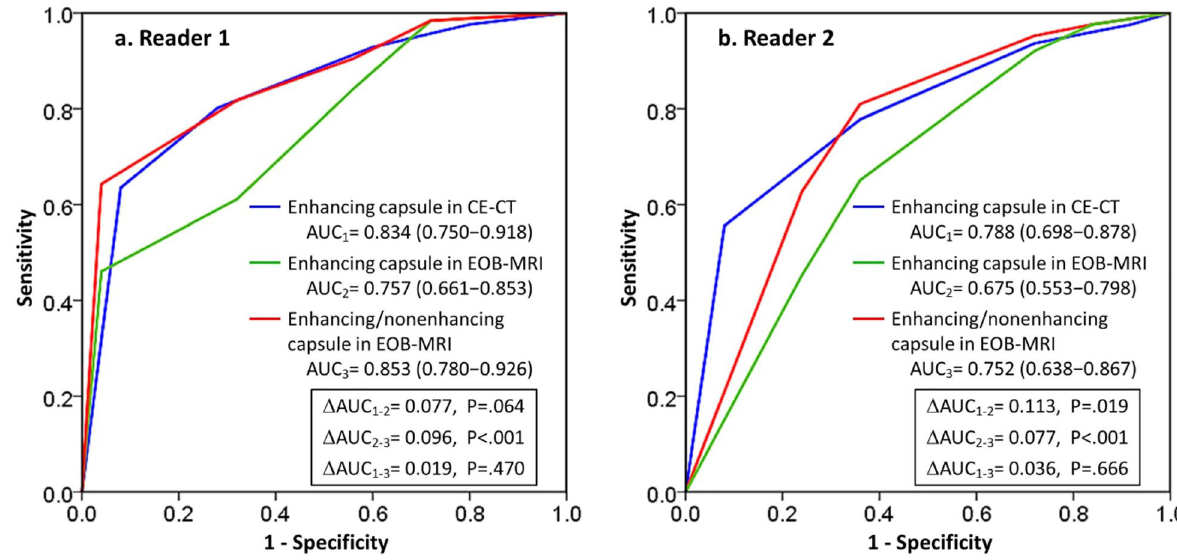
Figure 4. Receiver operating characteristics curves for enhancing capsule in CE-CT (blue), enhancing capsule in EOB-MRI (green), and enhancing/nonenhancing capsule in EOB-MRI (red) for the diagnosis of histological capsule in ( a ) reader 1, and ( b ) reader 2. AUC = area under the receiver operating characteristic